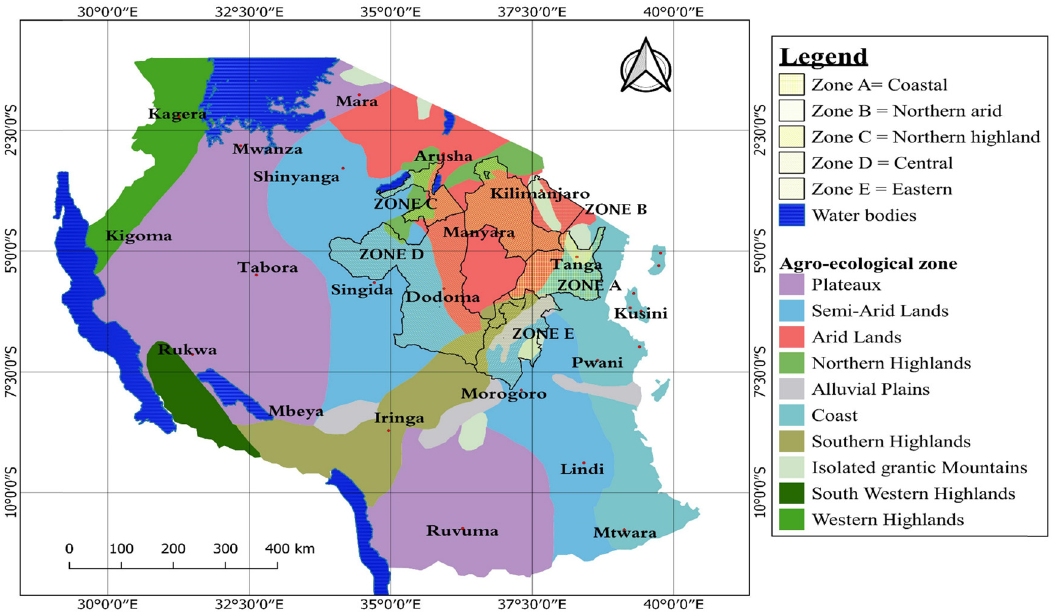
Figure 3: A new map showing the relationship between agro - ecological zones of Tanzania as per MAFSC [ 24 ] and areas growing Lablab in Tanzania as per this survey study. All the Lablab growing areas were located in arid or semi - arid lands to su ffi ce fi ndings that Lablab does not need much rainfall [ 6 ]